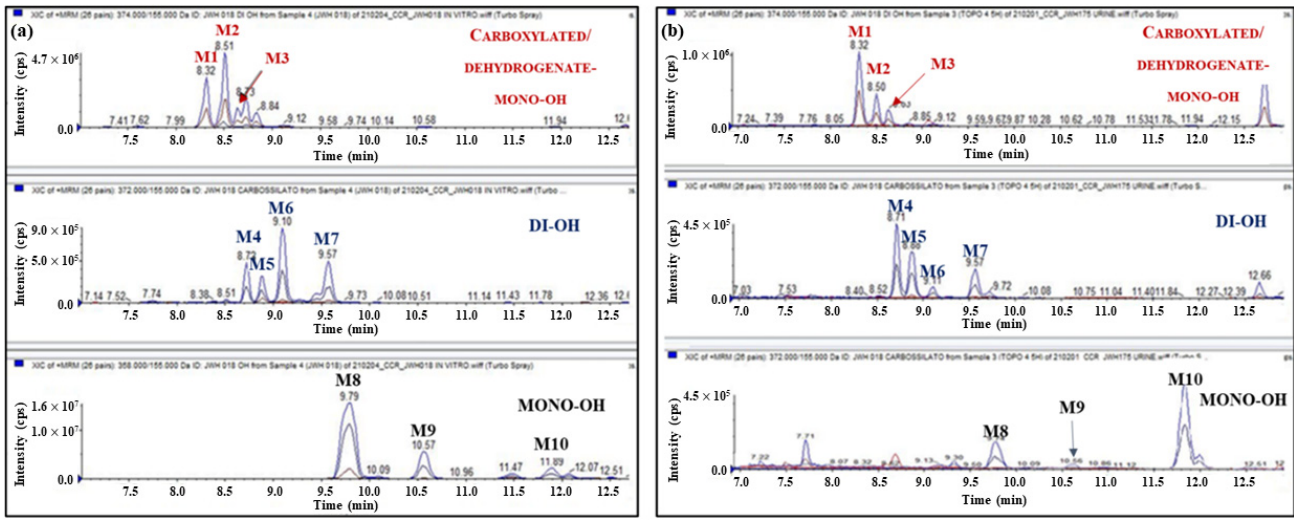
Figure 9. Extracted chromatograms obtained from the analysis of a representative urine sample collected from mice after JWH-175 administration ( a ) and from the analysis of samples obtained by incubating JWH-018 in the presence of HLMs ( b ). The phase I metabolites in common between JWH- 018 and JWH-175 are three di-hydroxylated metabolites (M1–M3), four